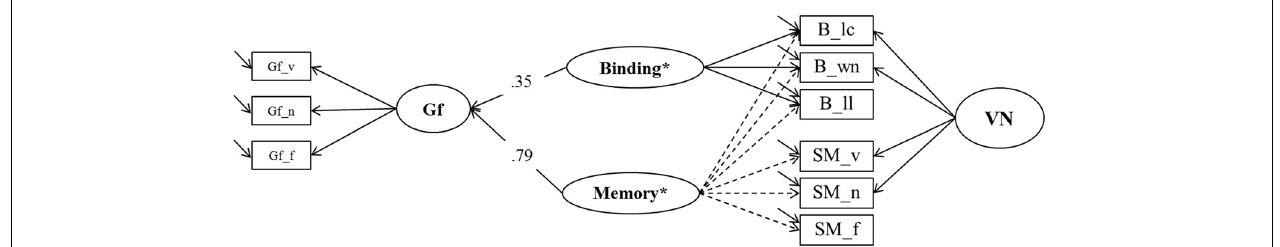
FIGURE 9 | A first structural model estimating explained variance in Gf by means of binding and secondary memory indicators (Model 6a). Gf, Fluid Intelligence; VN, Verbal-Numerical Content